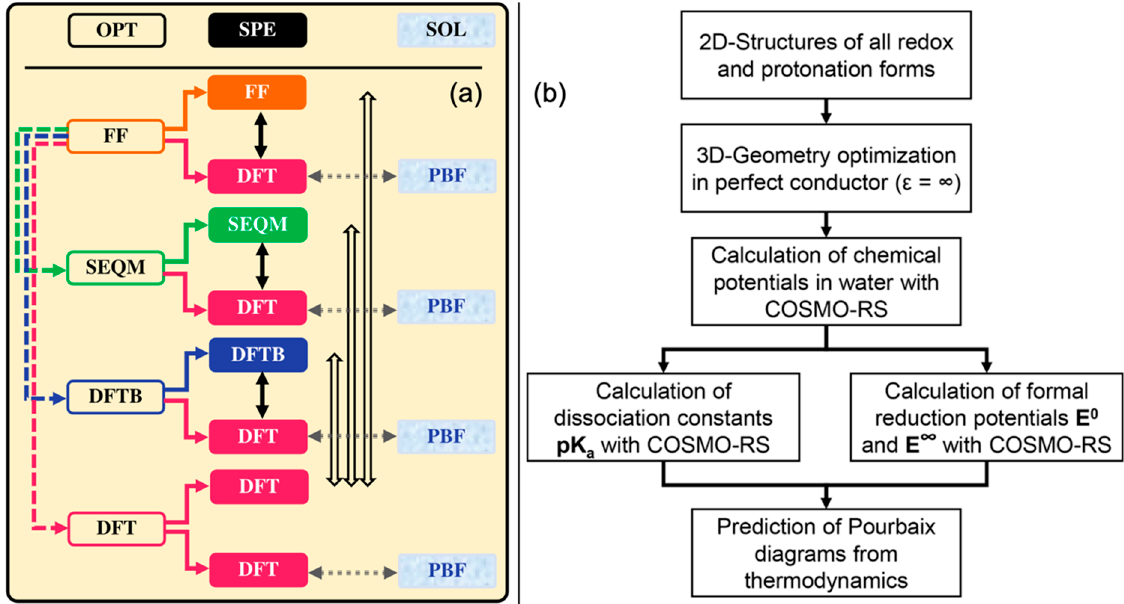
Figure 4. ( a ) Schematic diagram showing the workflow for geometry optimization (OPT) and single point energy (SPE) calculations at various levels of theory used by Zhang et al. [55] (Figure adapted from Ref. [55] under Creative Commons Attribution 4.0). The hollow arrows denote the differences between gas ‐ phase reaction energies obtained at different levels of theory. The solid black arrows denote the differences between energy computed using DFT on a fixed geometry obtained from a lower ‐ level preceding theory and the geometry computed at that lower ‐ level preceding theory. The dotted gray arrows represent the solvation effect from gas ‐ phase SPE to solution ‐ phase SPE when the implicit solvation model is considered. ( b ) Methodology of prediction of Pourbaix diagrams from COSMO ‐ RS employed in the work of Gaudin et al. [57]. (Figure adapted from Ref. [57] under Creative Commons Attribution 4.0)